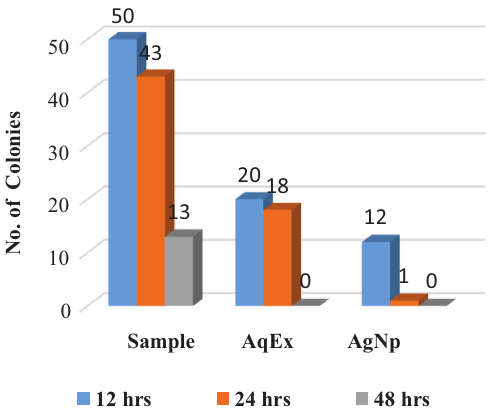
a) b) c) Plate 1. Sample treated with AgNP and AEIC of Imperata cylindrica in 12 hrs: a – Control sample; b – Treated with AEIC; c – Treated with AgNP